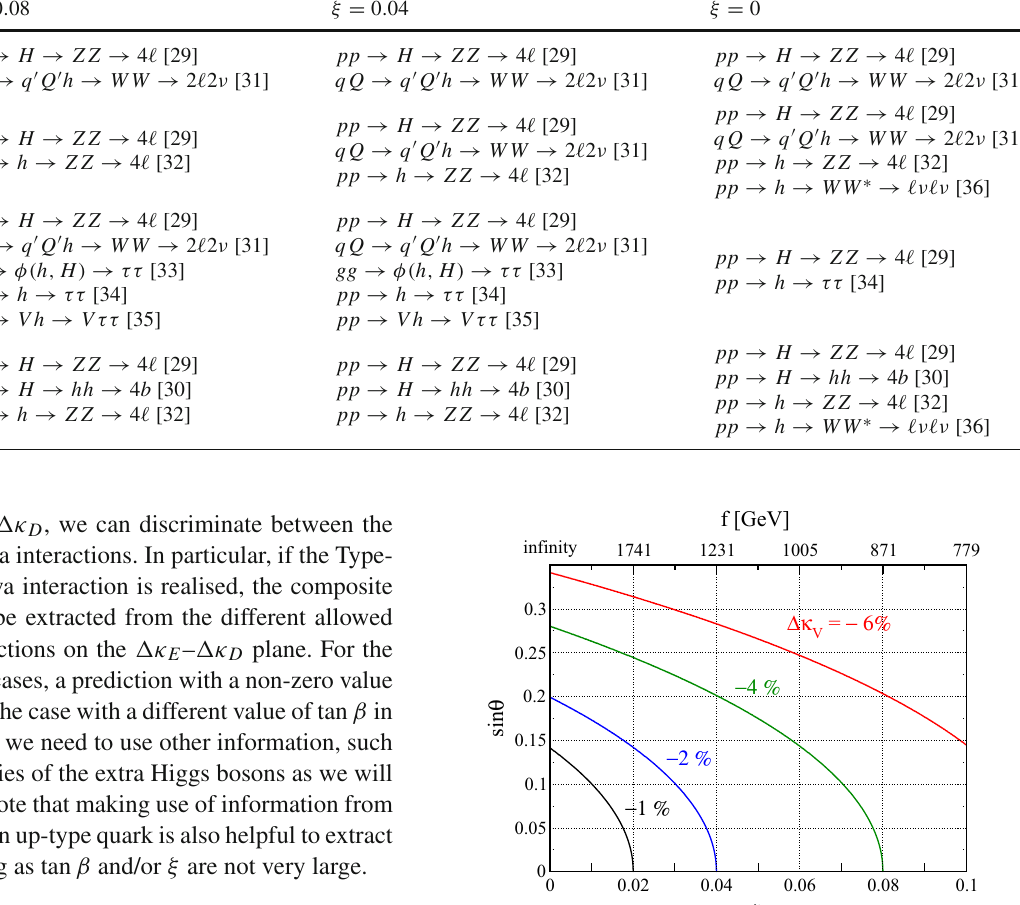
wave amplitude matrix has terms proportional to s ξ , thus indicating that an UV completion of the theory is needed at √ s = 1TeV. high energy. Here we fix In Fig. 4, we show the allowed parameter region on the (tan β , m (cid:8) ) plane for the three benchmark points, where m (cid:8) = m H ± = m A = m H . The region above each curve is excluded by perturbative unitarity or vacuum stability, so that this figure shows the absolute theoretical upper limit on m (cid:8) . Different colours of each curve show different choices of the ratio M / m (cid:8) , being 1, 0.8. 0.6 and 0.4. We can see that, typically, the unitarity and/or the vacuum stability bounds become stronger as the value of tan β increases. In addition, the case with M / m (cid:8) (cid:2) 1 tends to have a larger allowed value of m (cid:8) as compared to the case with M / m (cid:8) = 1. Fol- lowing this result, we take tan β = 2, m (cid:8) ≤ 500 GeV and M / m (cid:8) = 0 . 8 for the following